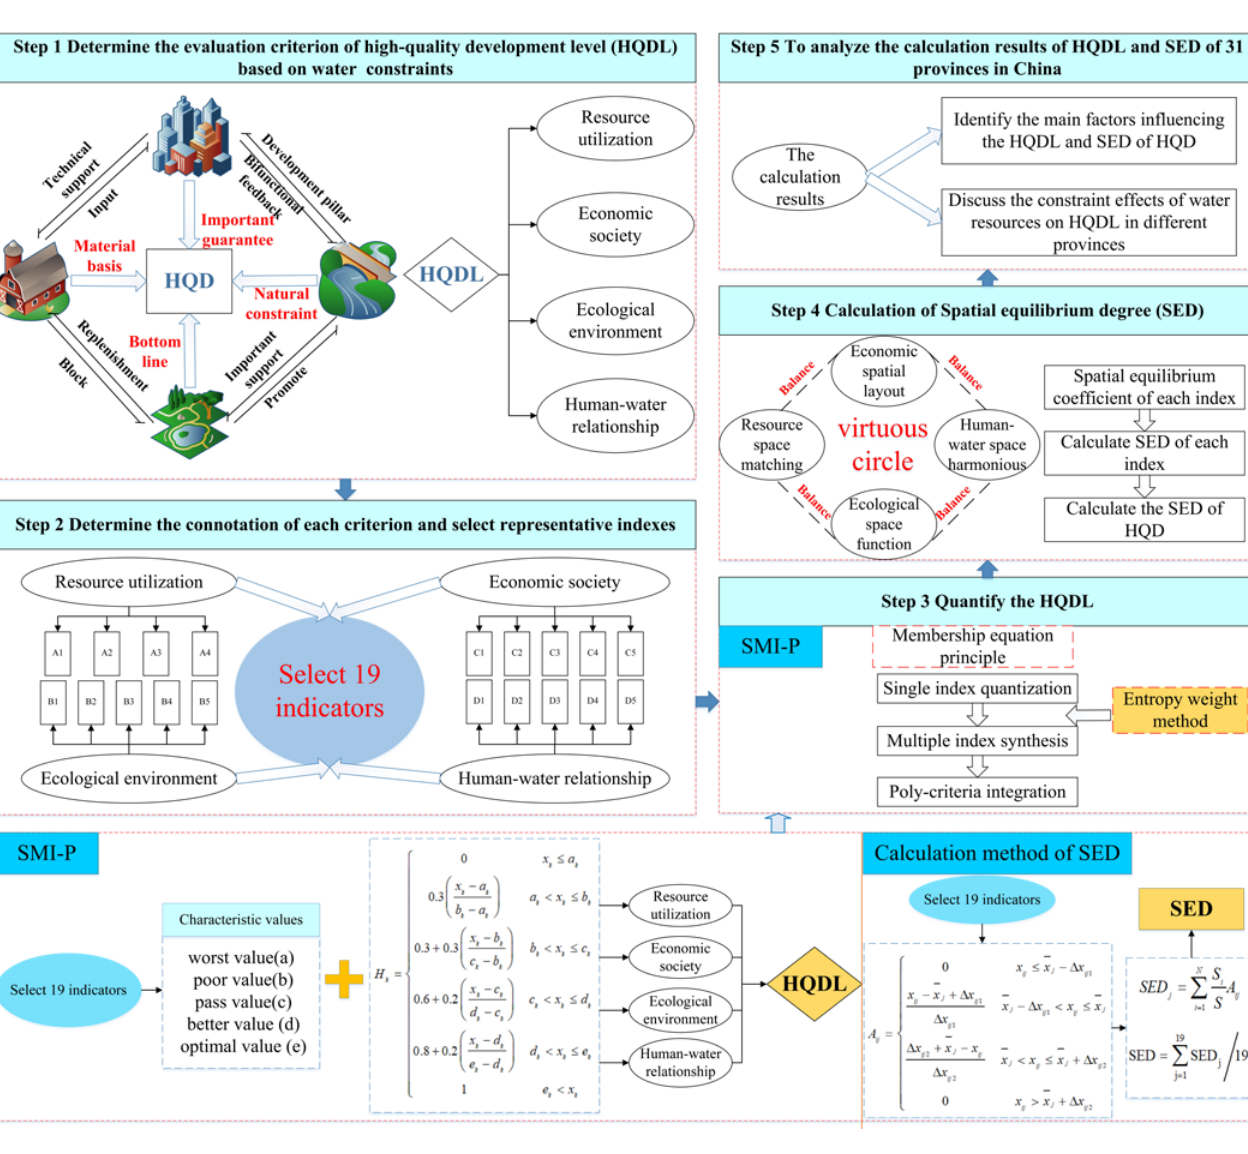
Figure 1. Research methodology and evaluation ideas.